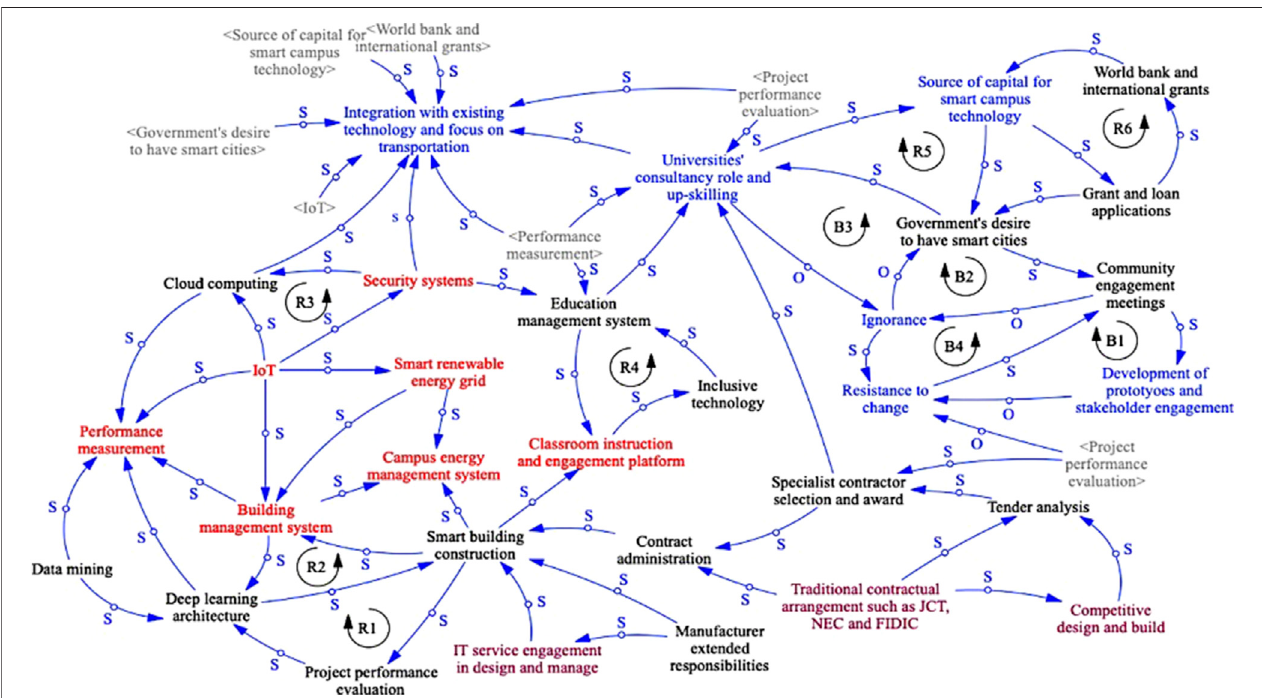
FIGURE 4 | Causalloopdiagramshowingtransferenceofknowledgeandtechnologiesinsmartcampusestocities(Legend:Redvariables (cid:1) smartcampusinfrastructure; Purple variables (cid:1) smart campus procurement, contracting and construction; Blue variables (cid:1) opportunities and challenges for micro-transferring smart campus infrastructures and knowledge to cities; In black (cid:1) new variables that emerged from the causal loop; S (cid:1) Positive; O (cid:1) Negative; R (cid:1) Reinforcing loop; B (cid:1) Balancing loop). Source: Authors.